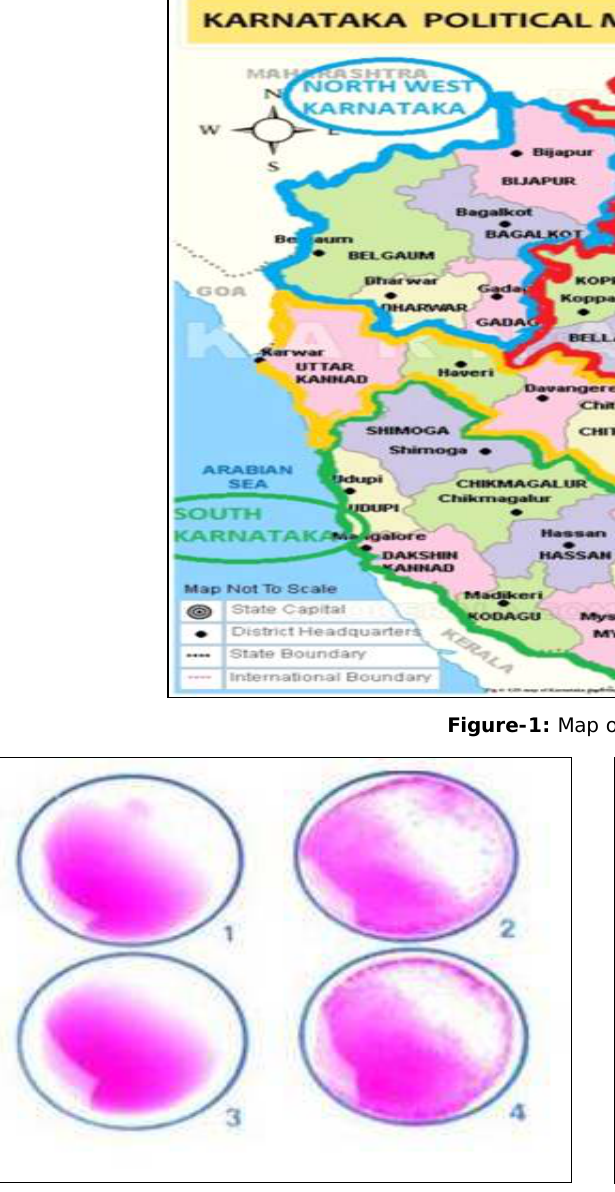
Figure-3: Standard Tube Agglutination Test